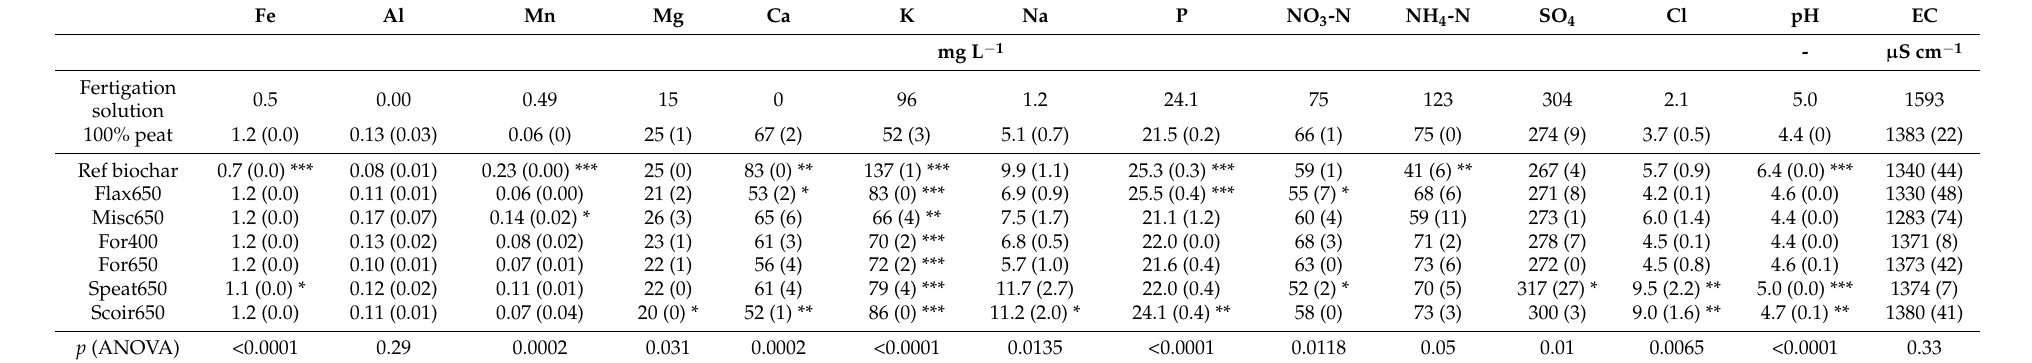
Table 2. Composition of the fertigation solution and the leachates during the fertigation phase (weighed mean), average of two replicates with standard deviation in parentheses. The composition of the leachates between treatments is compared by ANOVA. The average composition of the leachate of the treatments with biochar are compared with the control treatment of pure limed peat by Dunnett (*: p < 0.05; **: p < 0.01; ***: p < 0.001). Codes of the biochars: See Table 1. Ref biochar: Reference biochar based on stone oak wood.